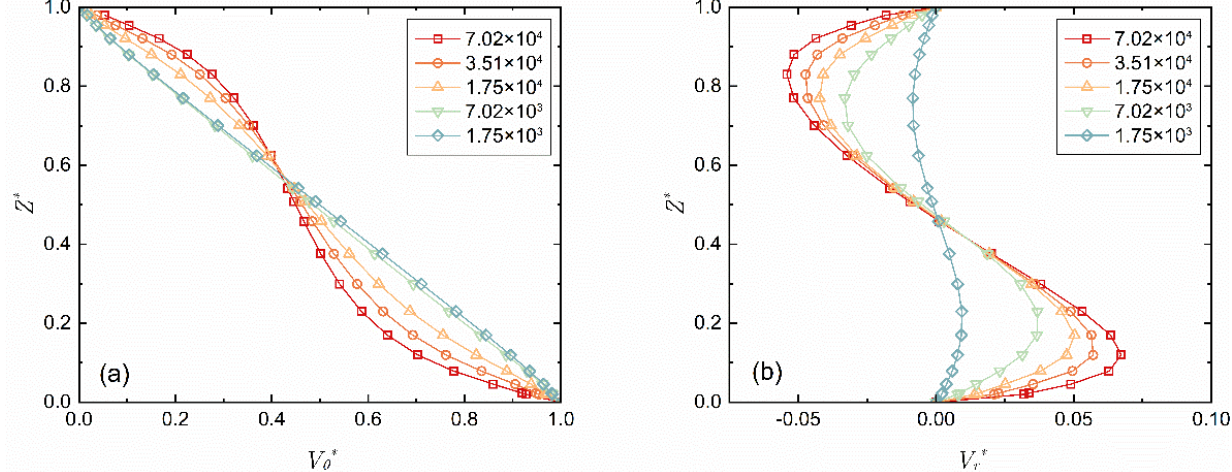
Figure 3. Distribution curve of the velocity component along the z-axis when r * = 0.8 and G = 0.027. ( a ) Circumferential velocity; ( b ) Radial velocity. ( a ) Circumferential velocity; ( b ) Radial